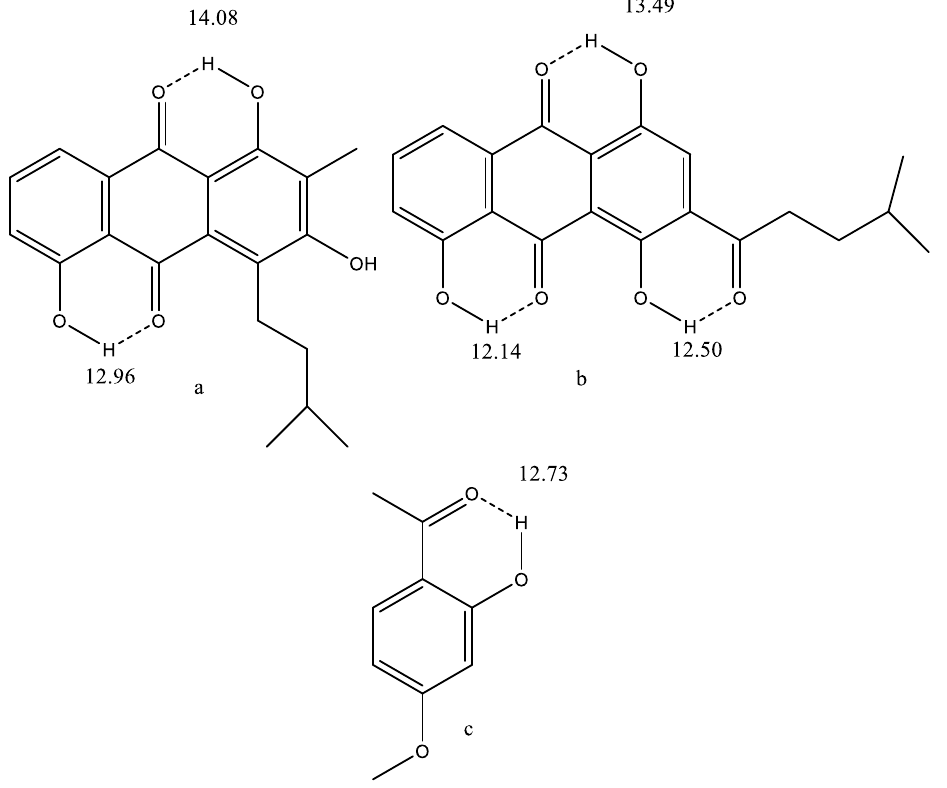
Figure 1. ( a , b ) Antitumor anthraquinones isolated from sea anemones. From Ref. [16]. ( c ) Paeonol from Ref. [17]. The numbers are OH chemical shifts. from Ref. [17]. The numbers are OH chemical